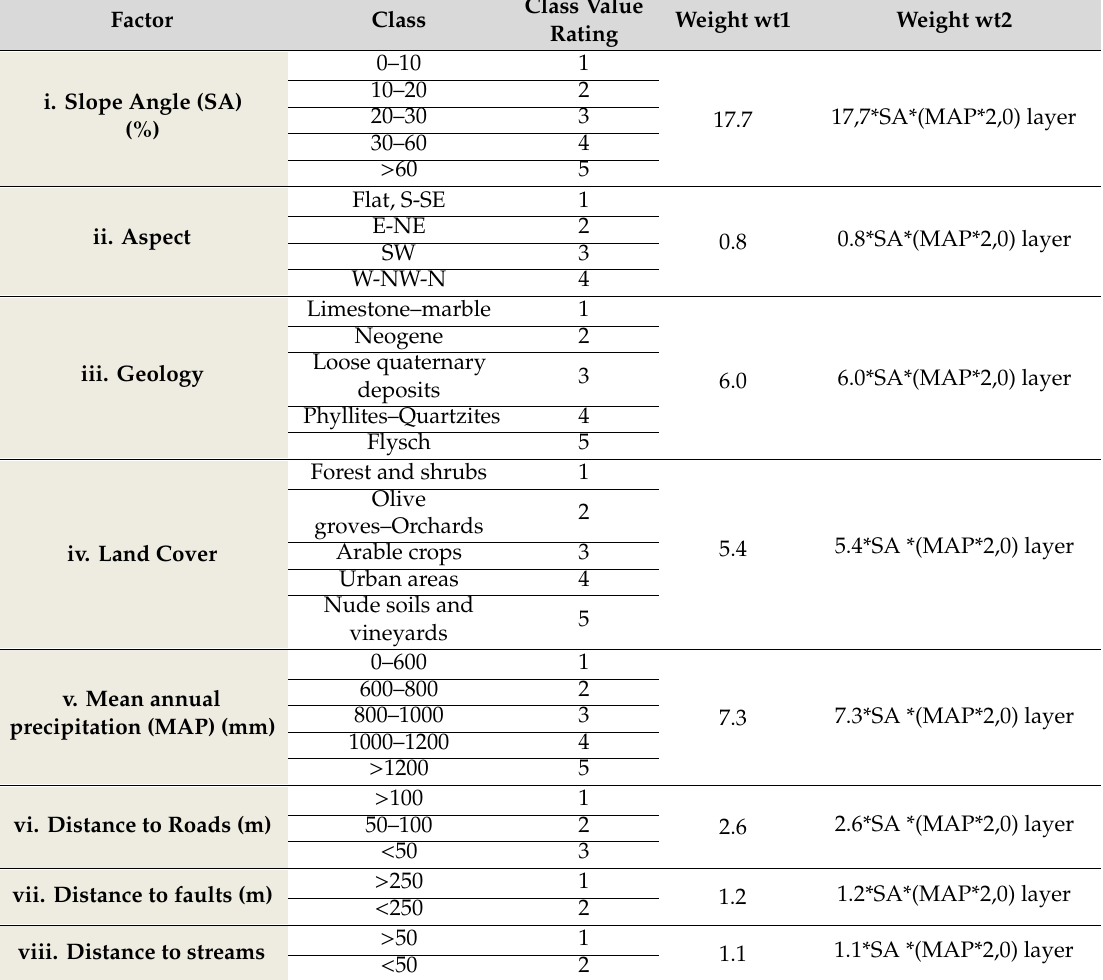
Table 3. Classification of the landslide controlling factors and categorization into rating classes according to their significance on Landslide